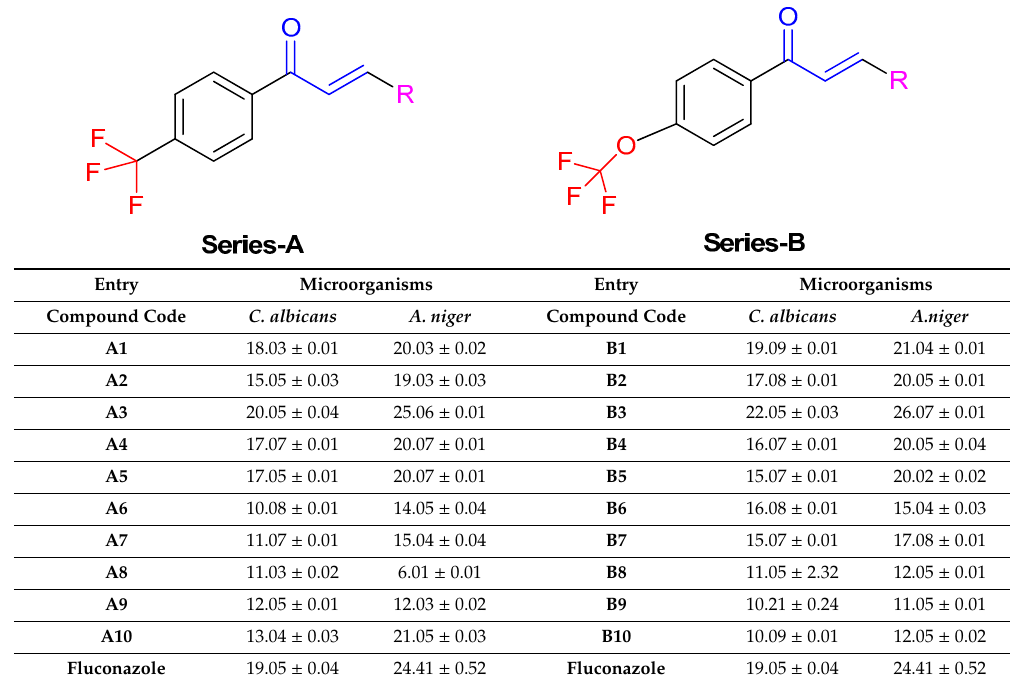
Table 2. Antifungal activity (zone of inhibition in mm) a of trifluoromethyl and trifluoromethoxy substituted chalcone derivatives (A1–A10 and B1–B10).